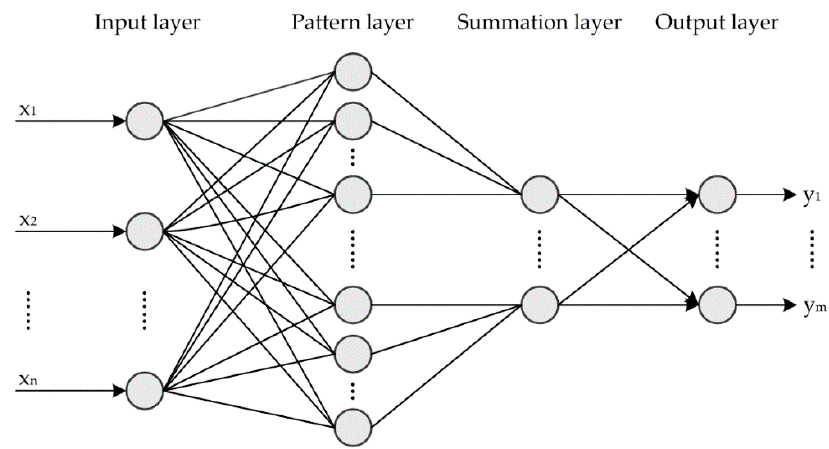
Figure 10. Architecture of the probability neural network.